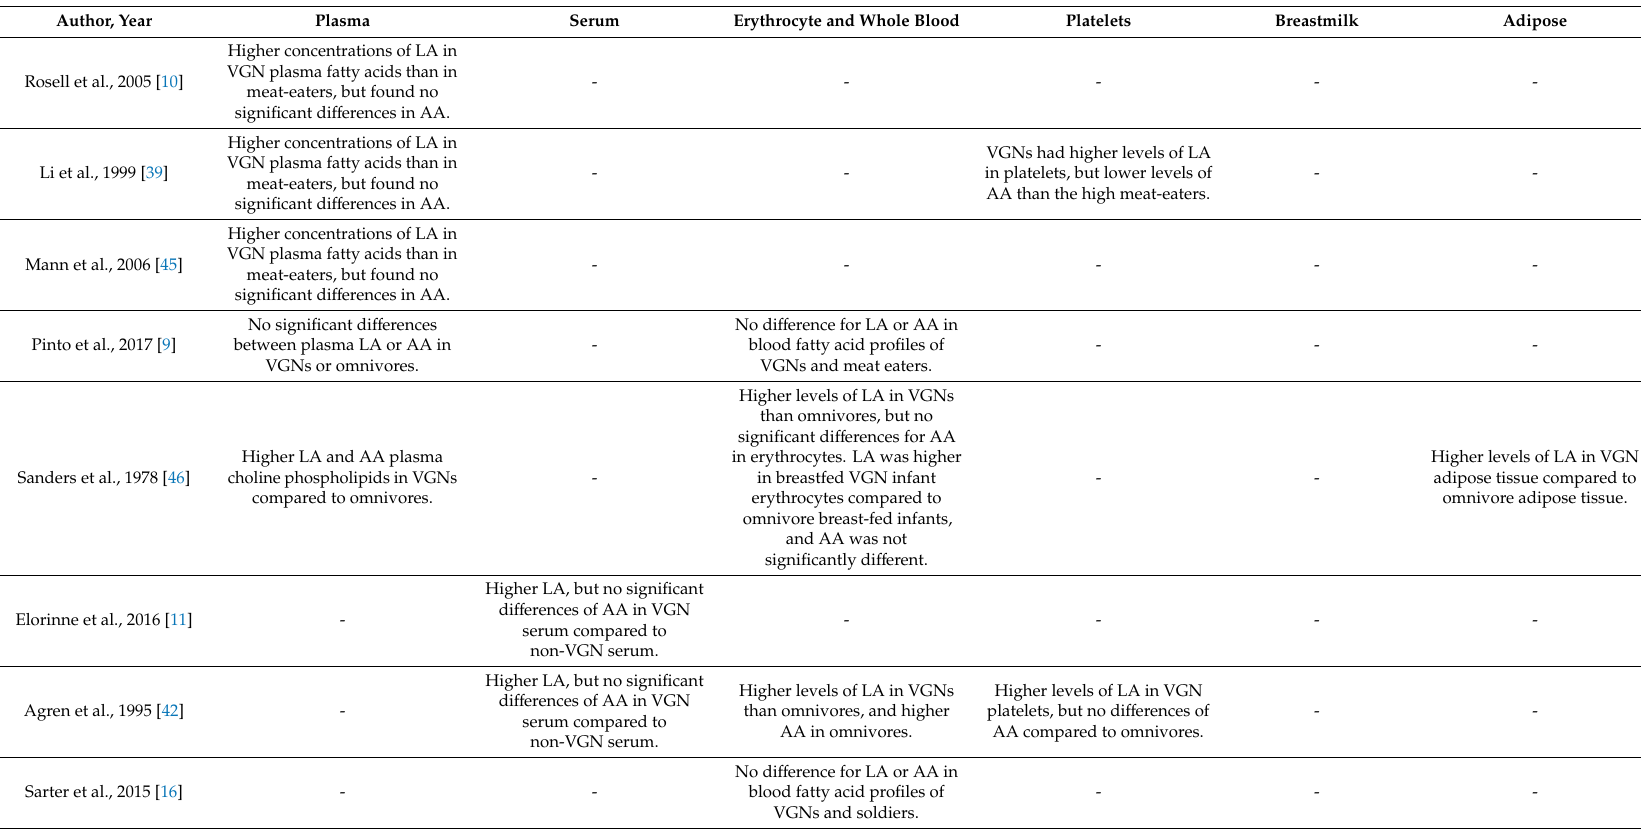
Table 2. Concentrations of n-6 fatty acids in various tissues by following a vegan or non-vegan diet (as cited in